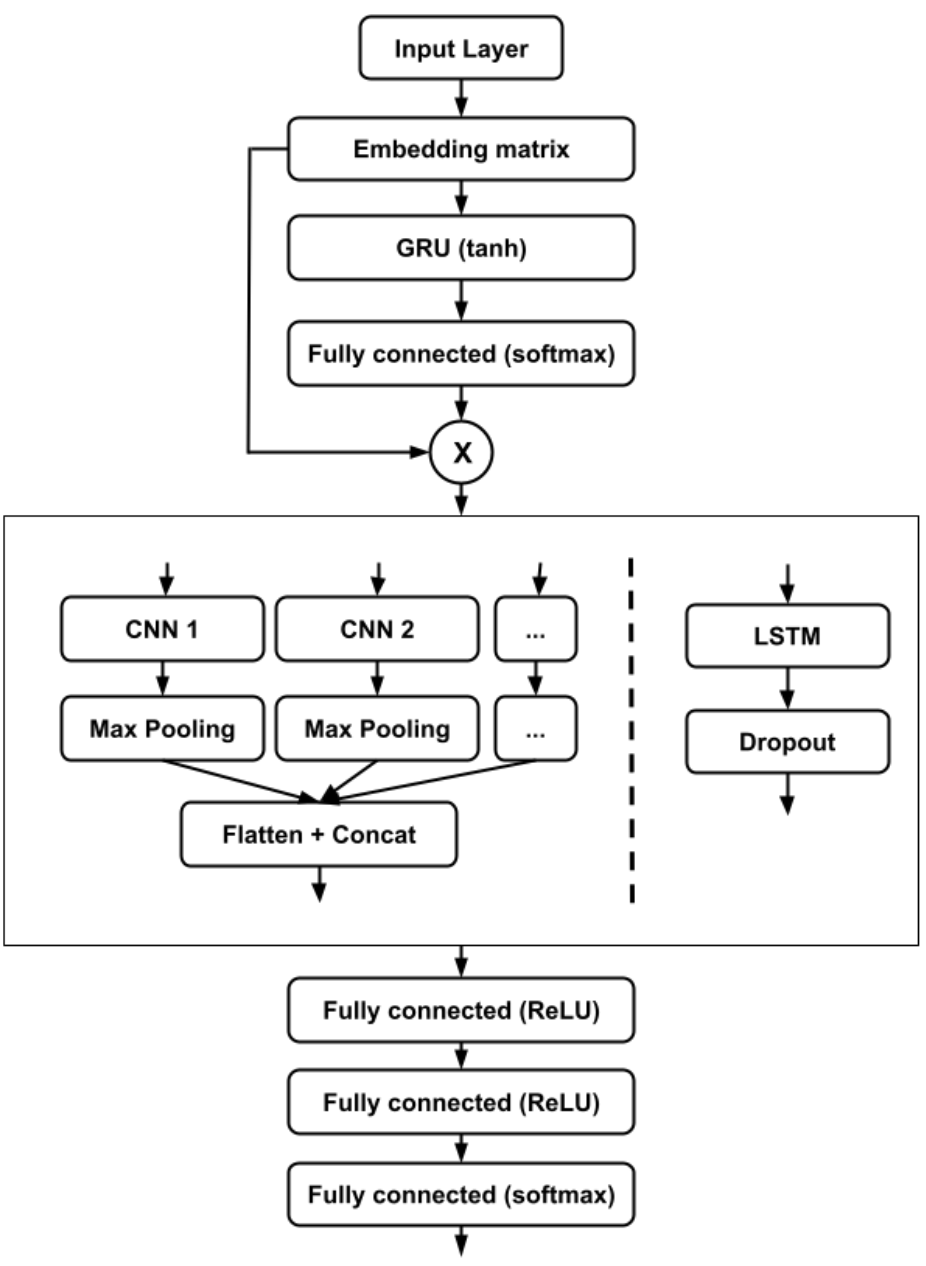
Figure 2. The architecture of the location prediction algorithm. Both approaches are shown in the same image, as they share the input, attention and output